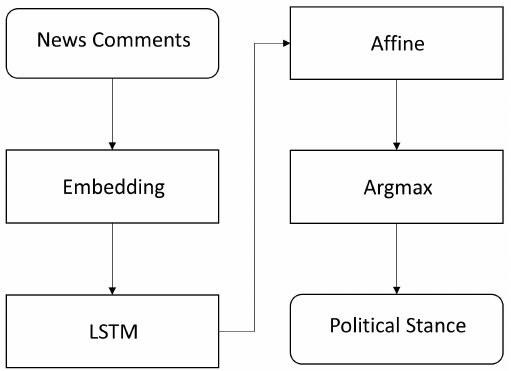
Figure 5. Seq2seq model to classify each user’s political stance. Table 1. Parameters of the proposed deep learning model.